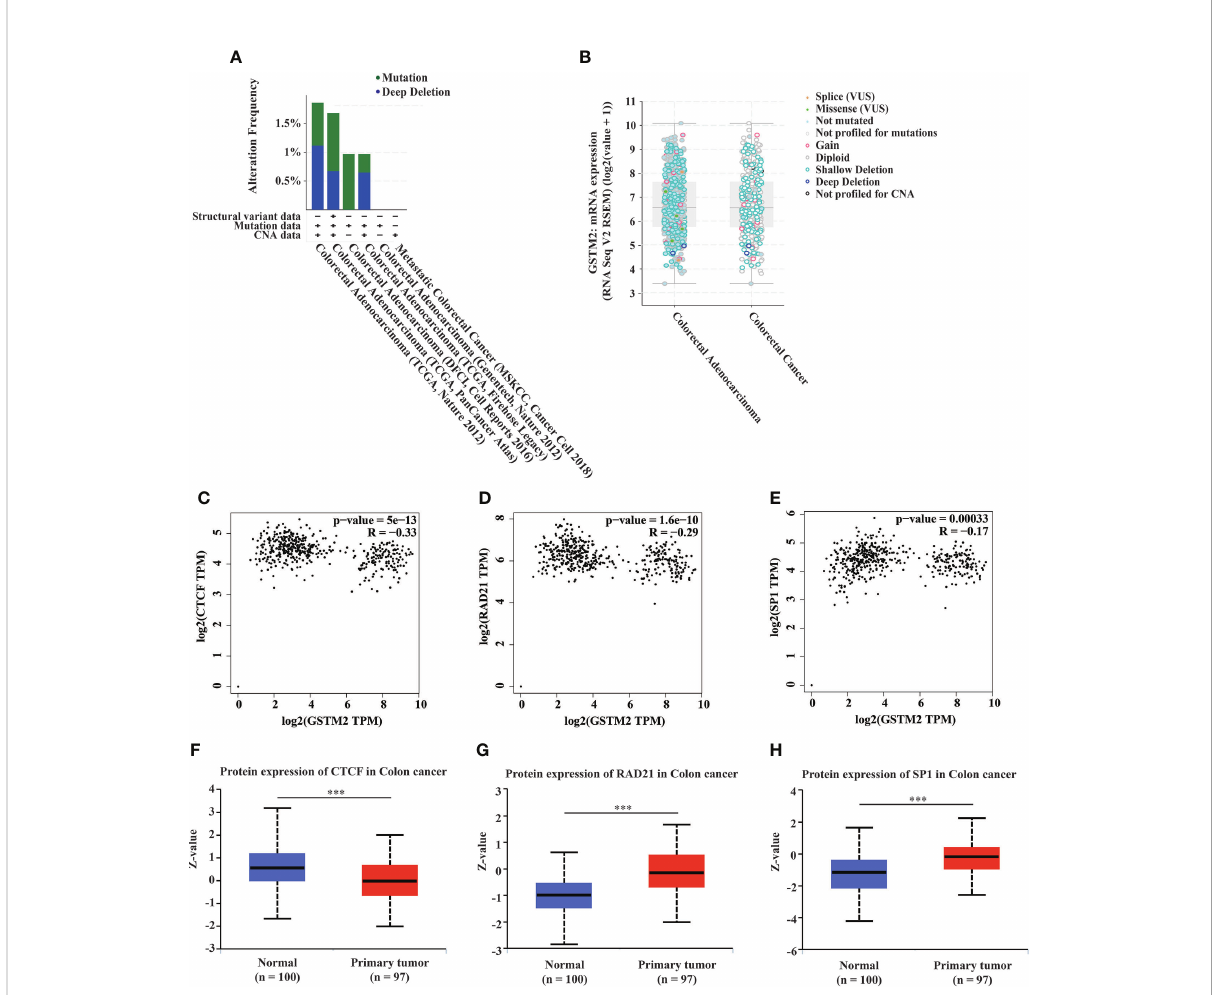
FIGURE 4 Two Potential Reasons for the Down-regulation of GSTM2 in Human Colon Cancer. (A) The mutation type and frequency of GSTM2 in colorectal cancer. (B) The GSTM2 expression in tumor tissues from colorectal cancer patients with different GSTM2 mutations. (C – E) The protein expression correlation between GSTM2 and CTCF, RAD21, SP1 in colon cancer. (F – H) The protein expression of CTCF, RAD21, SP1 in colon cancer tissues versus normal tissues. ***p <